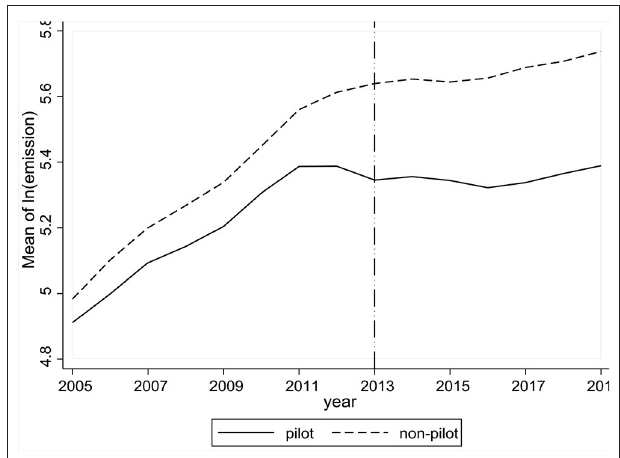
FIGURE 3 | Year-to-year average of ln(emission) within groups before and after